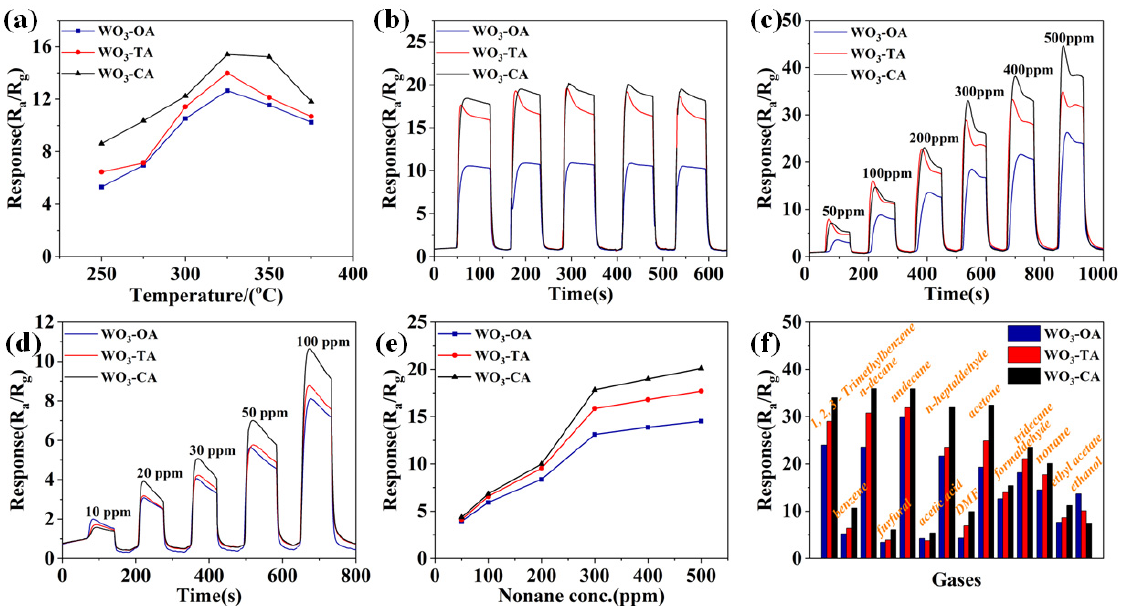
Figure 3. Gas sensitivity test at 35–50% relative humidity: ( a ) Working temperature and sensitivity; ( b ) Stability test at 300 ppm of acetone; ( c ) Decane response–recovery curve; ( d ) The response–recovery curve of undecane at lower concentrations; ( e ) The relationship between the sensitivity and the gas concentration in a nonane atmosphere; ( f ) Response values for 500 ppm VOCs gas at optimal operating temperature.